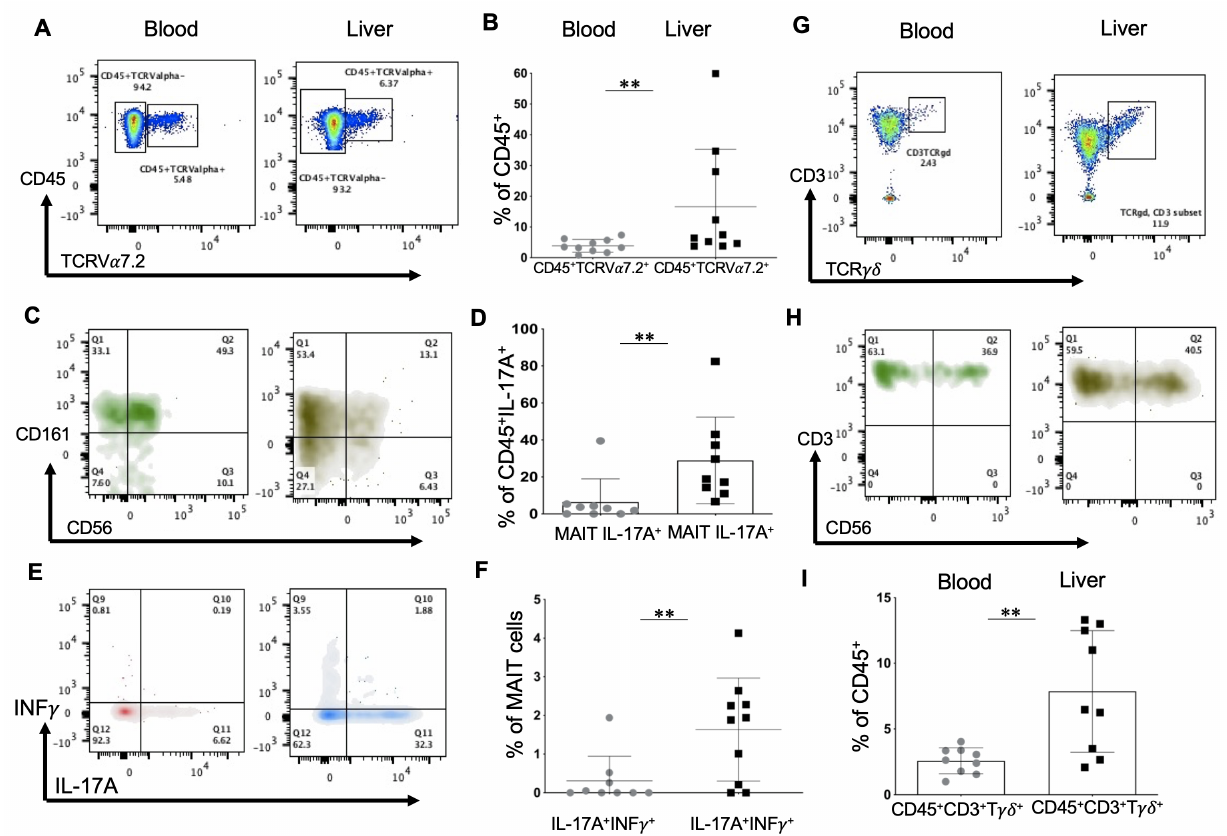
Figure 4. Human liver infiltration by MAIT and T γδ cells. ( A ) Representative flow cytometry plots of CD45TCRValpha7.2 + cells (MAIT cells) in blood and liver samples, ( B ) graphical representation, ( C ) their phenotype, ( E ) their secretion of IL-17A and INF γ . ( D ) Percentage of IL-17A + MAIT cells in the CD45 + IL-17A + lymphoid population in blood and liver samples. ( F ) Graphical representation of the proportion of IL-17A and INF γ double-positive cells among MAIT cells in blood and liver samples. ( G ) Representative flow cytometry plots of T γδ cells (CD45 + CD3 + TCR γδ + ), along with CD56 surface marker expression ( H ) in blood and liver. ( I ) Graphical representation of T γδ cells (%) among CD45 + lymphoid cells in blood and liver (Mann–Whitney test, ** p <